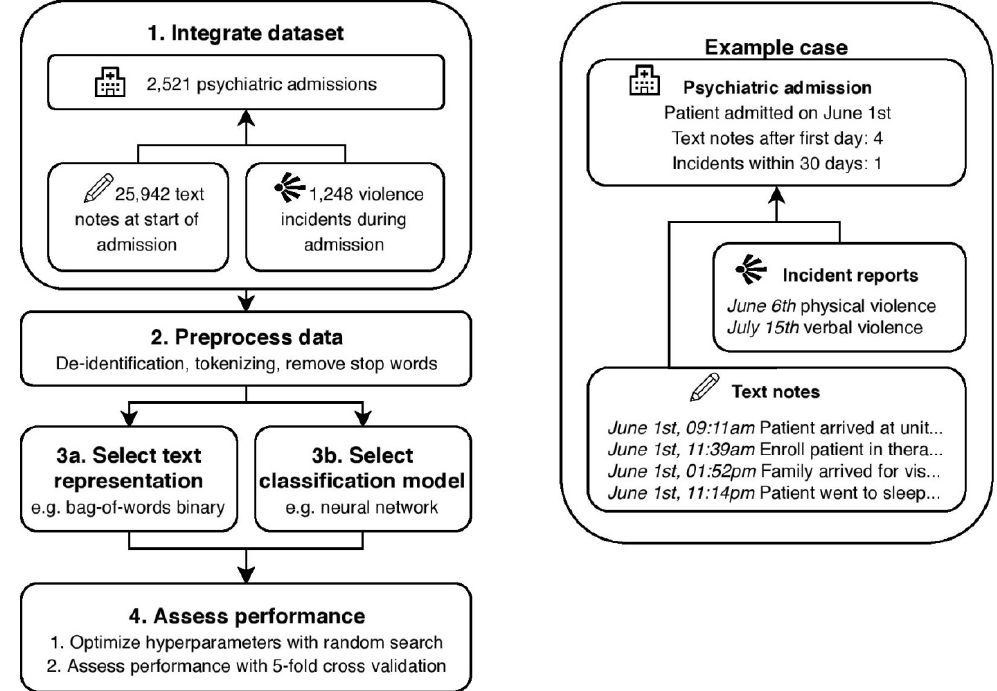
Figure 1. An overview of the proposed steps involved in comparing deep learning and classical machine learning techniques. On the right, a fictional example admission is shown. The details of the admissions in step 1 can be seen in Table 1. All text representations in step 3a are visible in Table 2, and the classification models of step 3b are shown in Table 3.